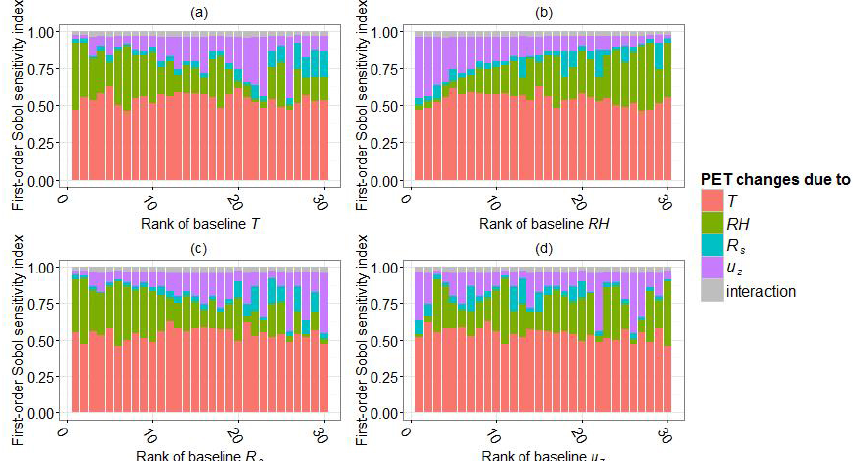
Figure 7. Sobol’ first-order sensitivity indices of the Penman–Monteith model for changes in the four climate variables (colored) and their interaction effects (gray), plotted against the ranking of the average level of each climate variable at 30 study